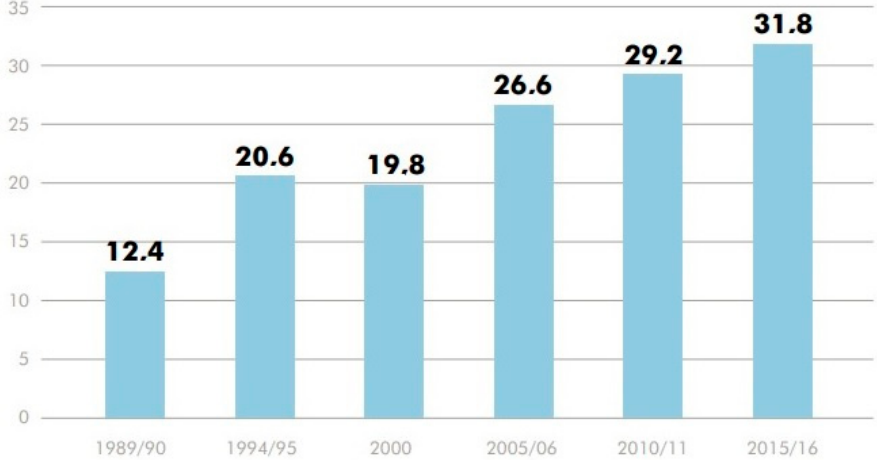
Figure 3. Evolution of average annual household expenditure on housing. (As % of total expenditure.) Source: [37,38].